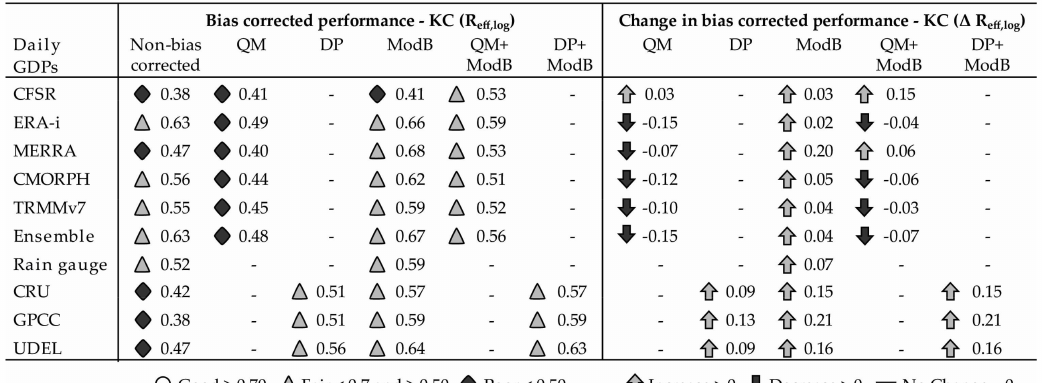
Table 6. Performance scores for KC discharge simulations. Performance is shown as R eff , log values for each bias correction technique